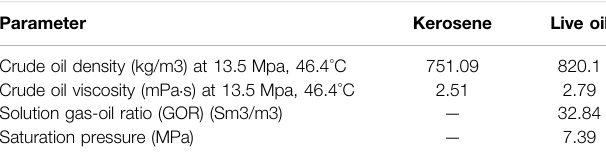
TABLE2| Measured propertiesfortheexperimentaloilsampleandcrudeoilused in simulation. Parameter